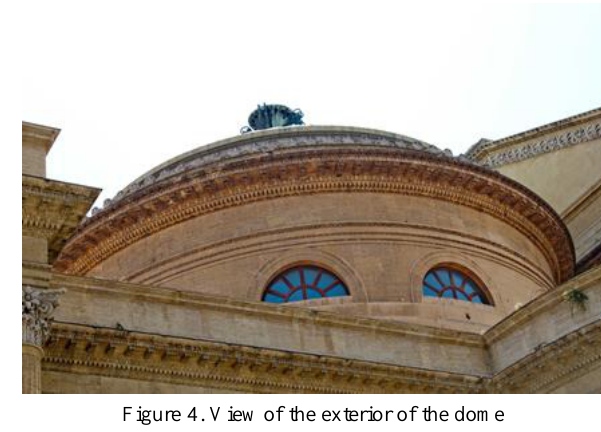
Figure 4. View of the exterior of the dome